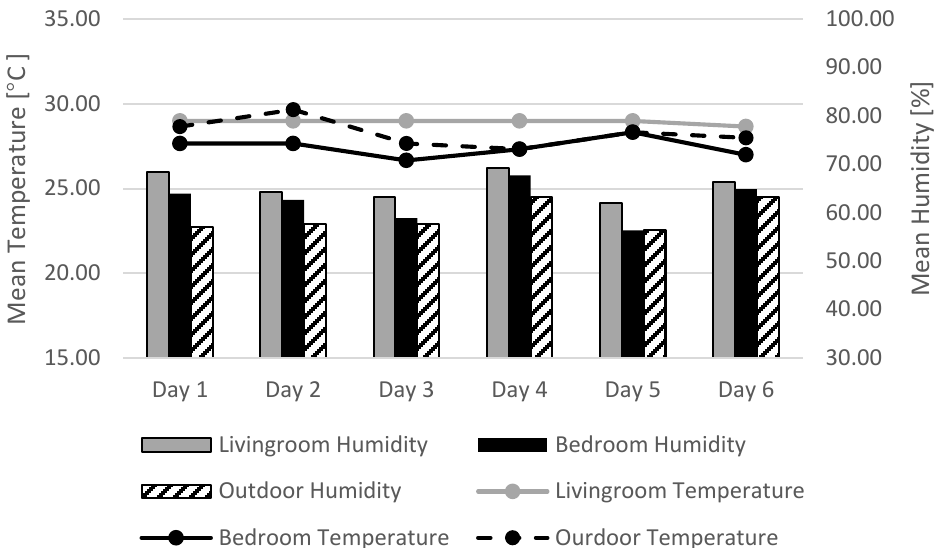
Figure 7. Indoor/outdoor temperatures and humidity averaged from 7.00 – 10:00, 12:00 – 15:00, and 17:00 – 21:00 (HRB2).